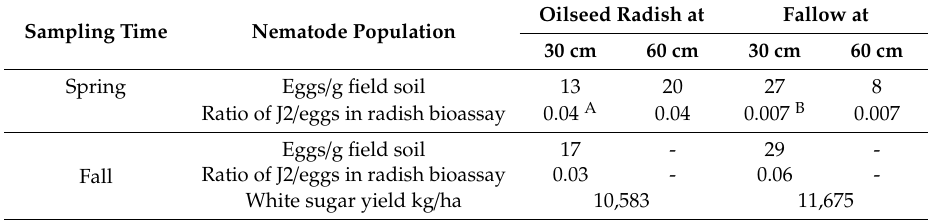
Table 1. Median numbers of Heterodera schachtii under oilseed radish and fallow at the Jeinsen location: egg population densities, penetration ratios of J2 in radish bioassay roots, and white sugar yields.